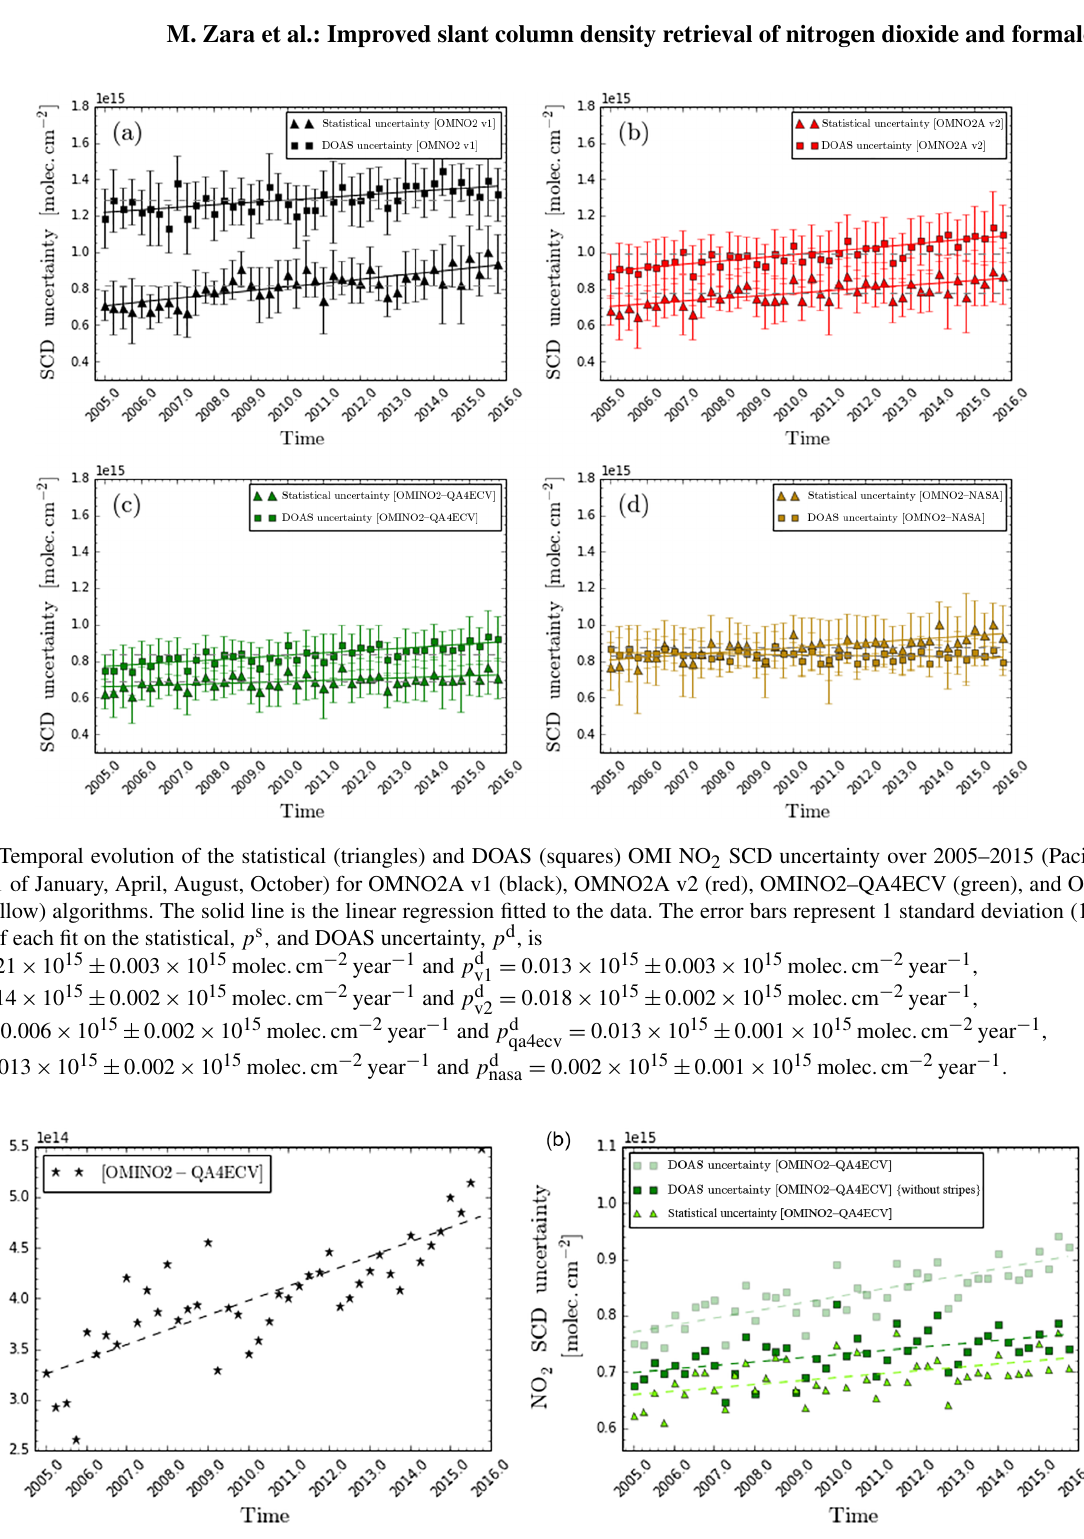
Figure 10. (a) Temporal evolution of the stripe-induced SCD uncertainty for OMINO2–QA4ECV. (b) Temporal evolution of the NO 2 DOAS SCD uncertainty for OMINO2–QA4ECV before (light green squares; as seen in Fig. 9c) and after (dark-green squares) the subtraction of the stripe-induced SCD uncertainty. The green triangles represent the temporal evolution of the NO 2 statistical SCD uncertainty (as seen in Fig.